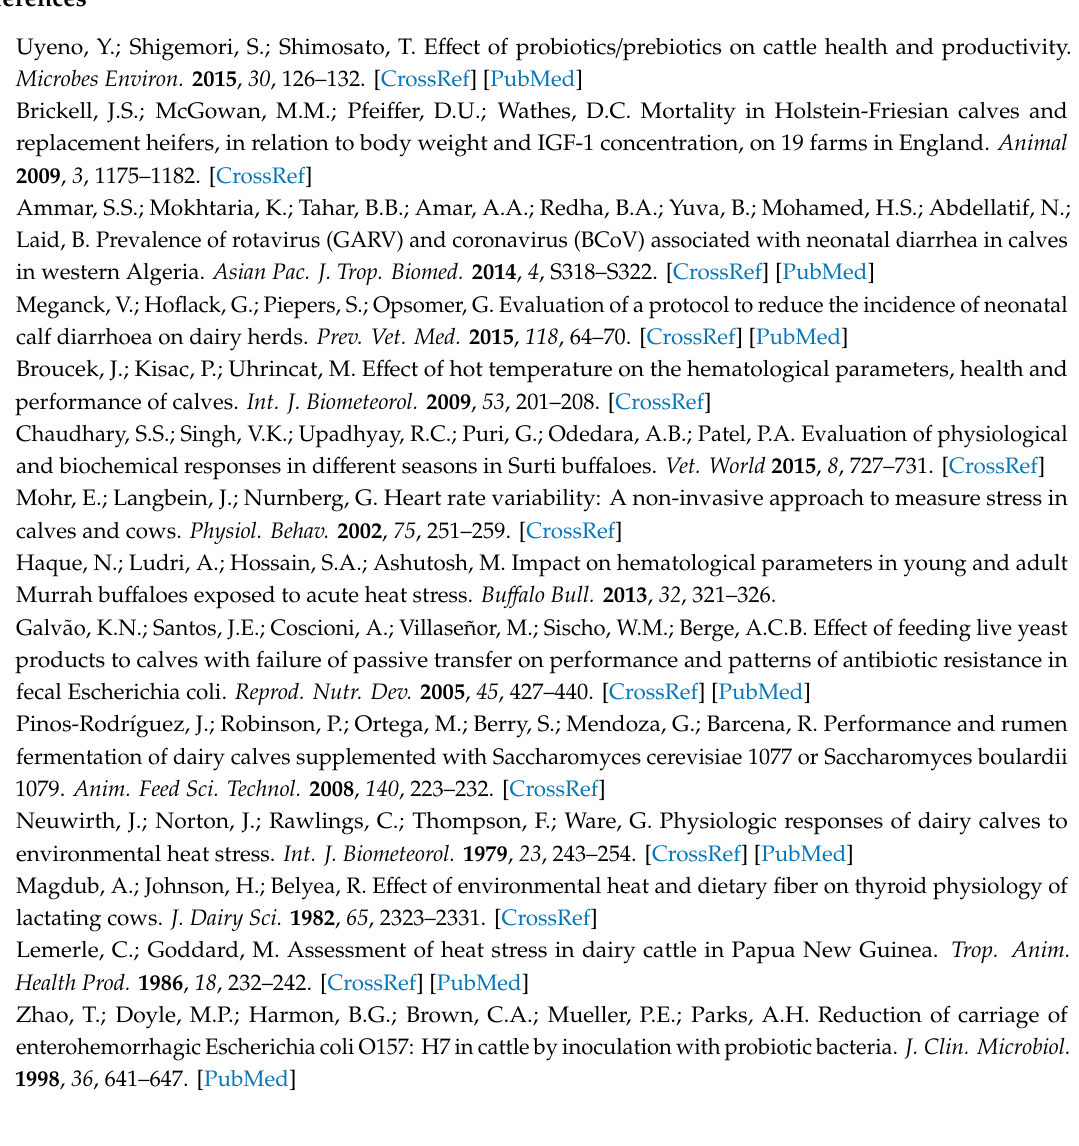
Table S1: Primers / probe sets used for quantitative real-time